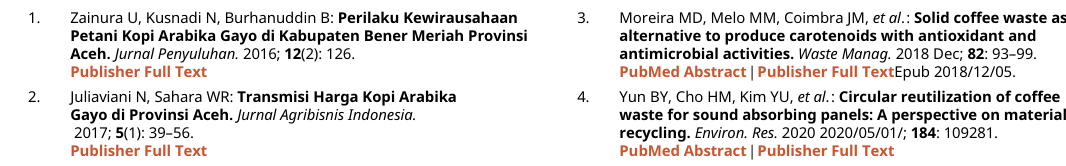
Figshare: PRISMA checklist for ‘ Coffee by-products as the source ofantioxidants: asystematic review ’ . DOI: https://doi.